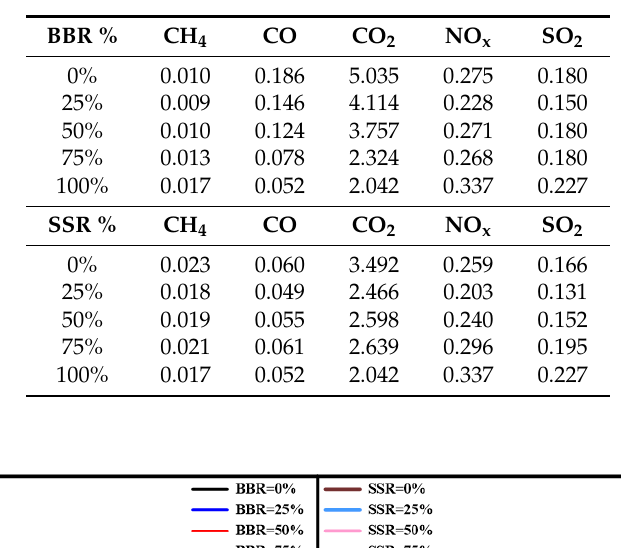
Table 5. Evolved gas production rates of different sludge-coal ratios (BBR) and sludge-shiitake ratios (SSR) (BBR = SSR = 100%: pure sludge).